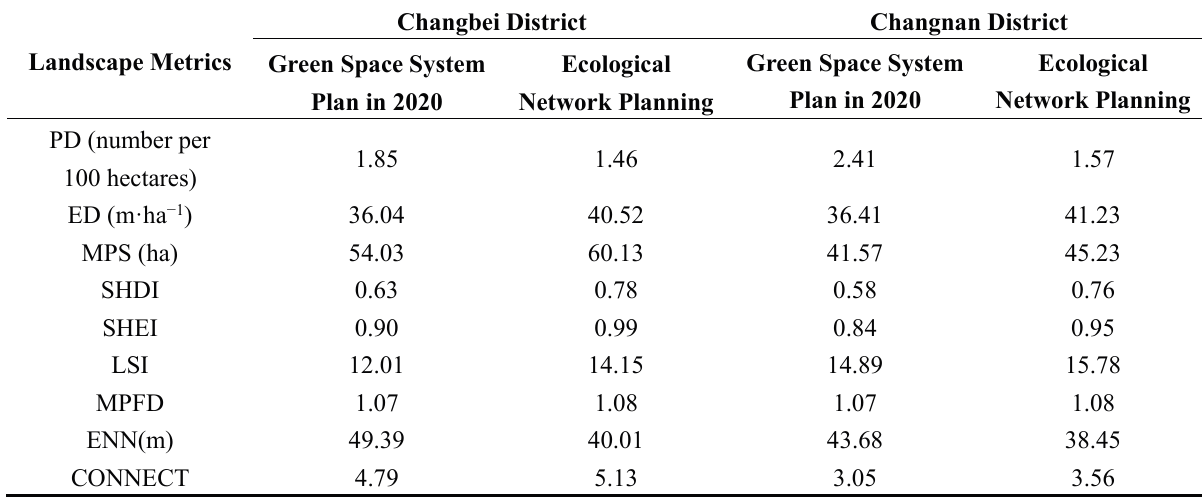
Table 4. Landscape metrics in different